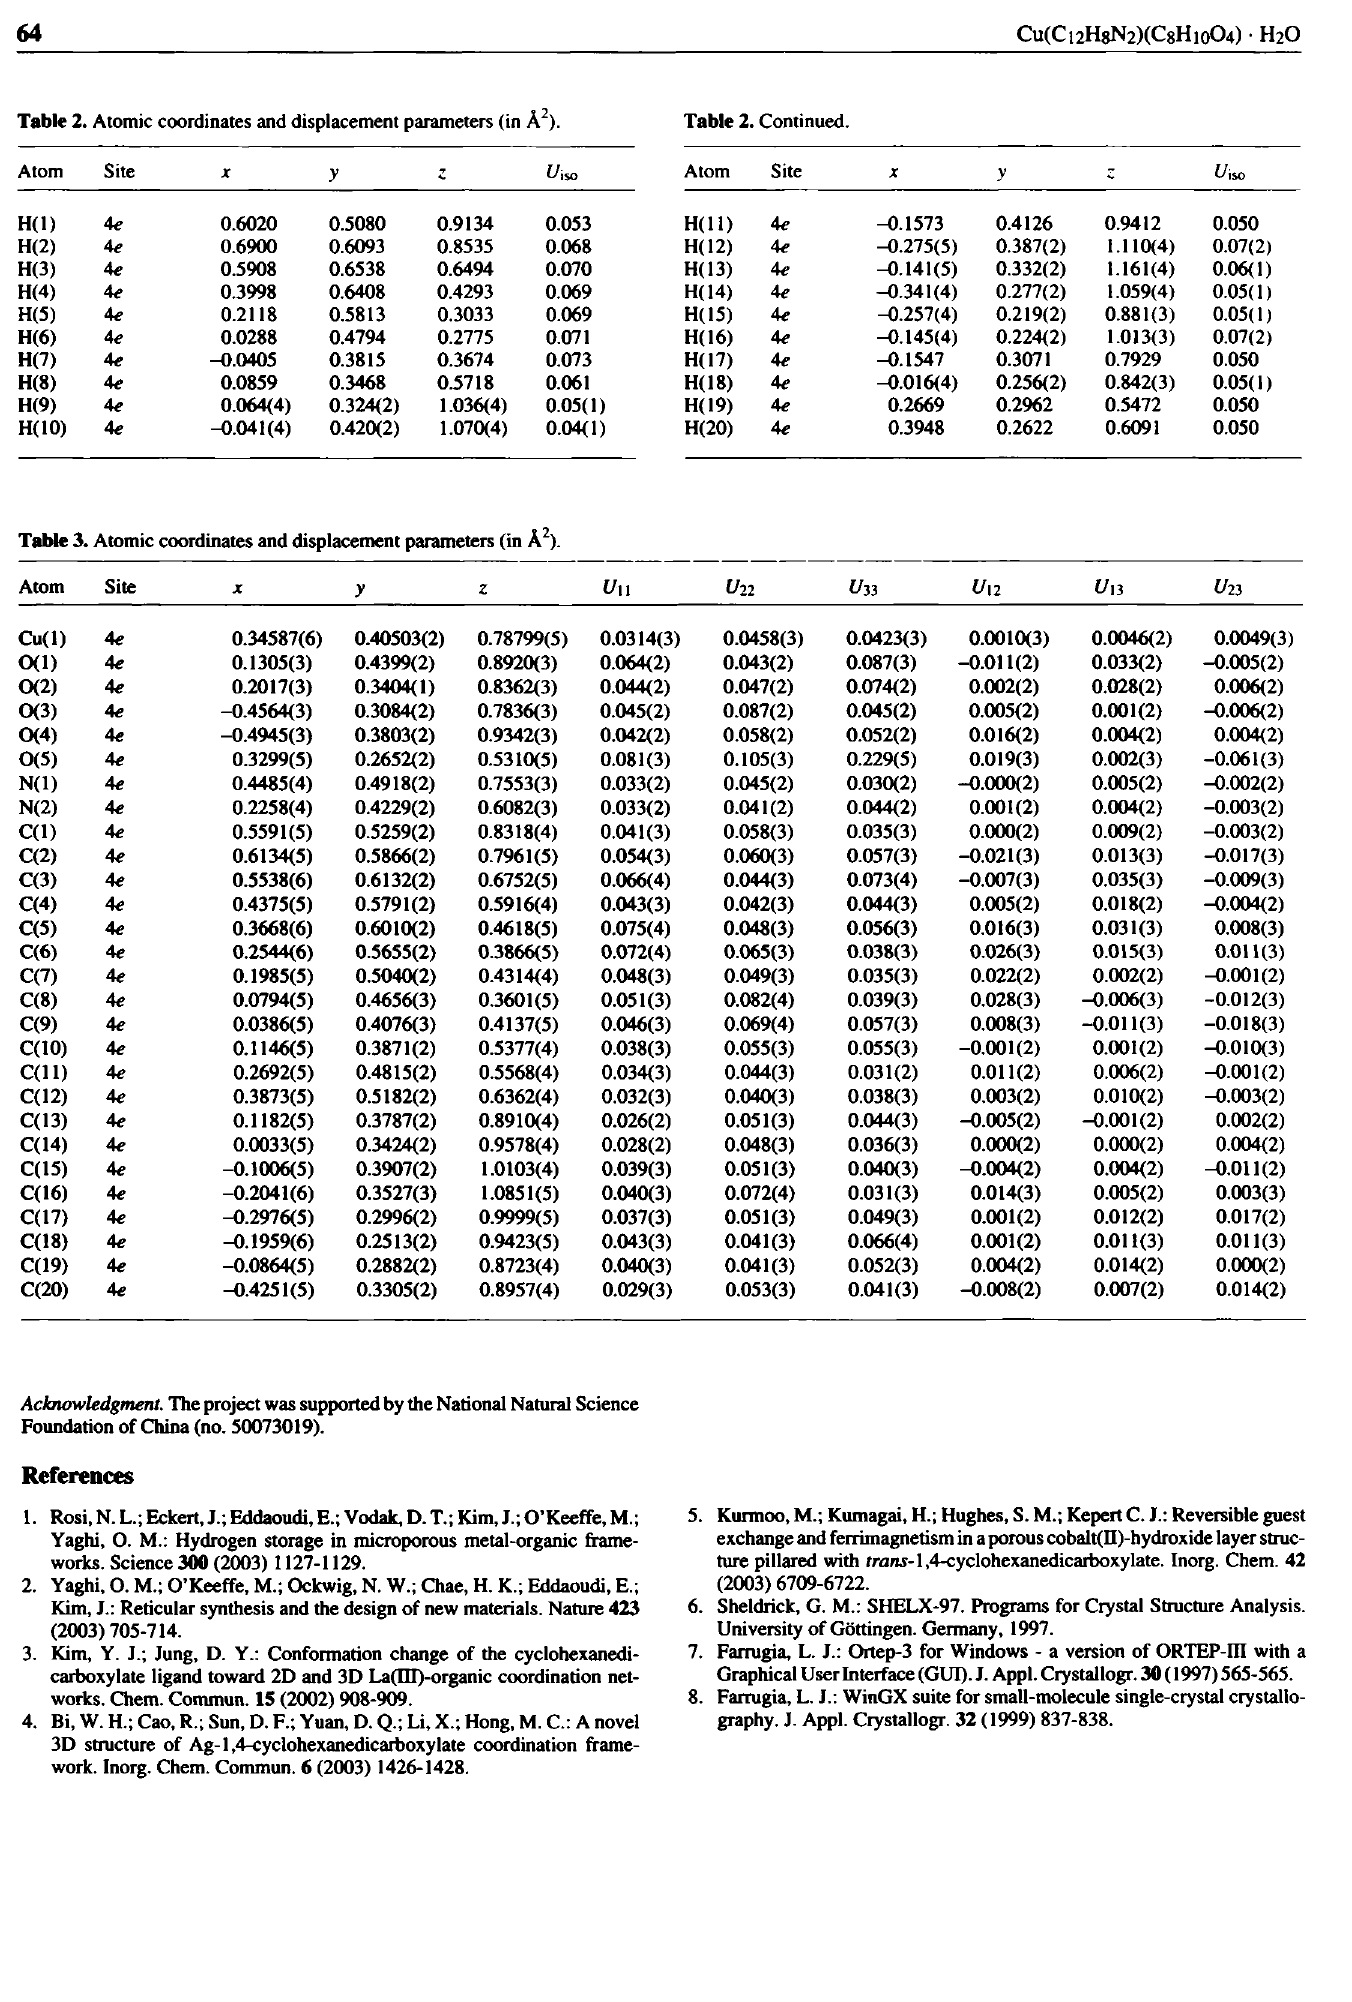
Table 2. Atomic coordinates and displacement parameters (in Â 2 ).